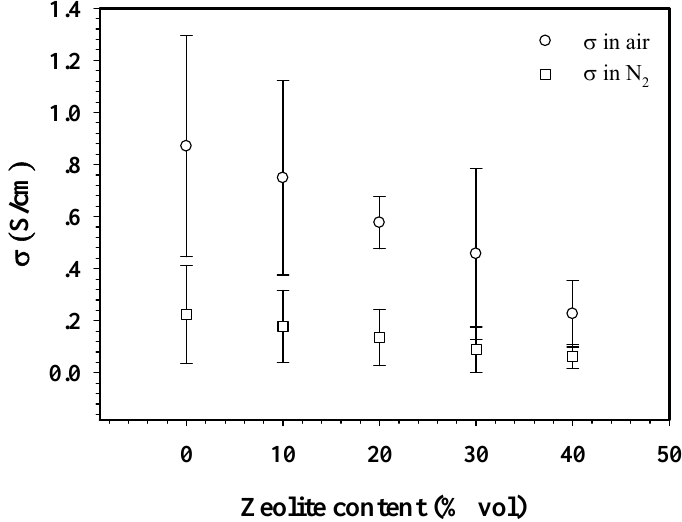
Figure 3. σ vs . zeolite% volume content of 50:1dPPP/NaZSM-5(23) composites in air and at 1 atm and (28 ± 1) °C; data shown were obtained from at least two N 2